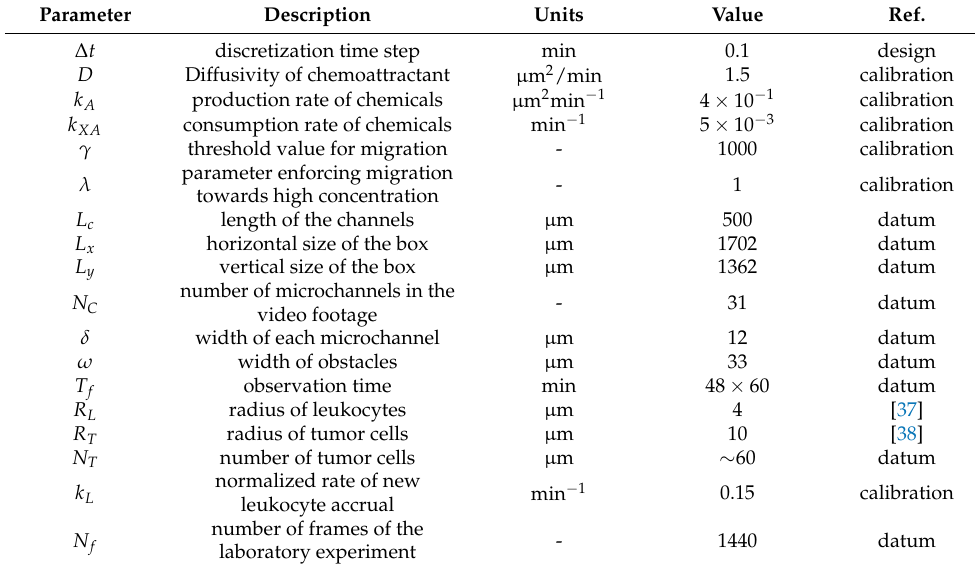
Table 1. Parameters of the